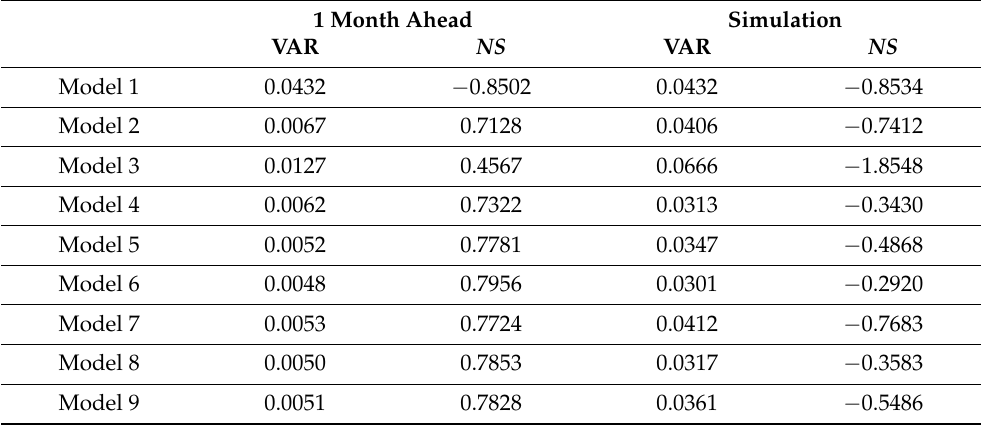
Table 3. VAR and NS values estimated for the testing set of data, for the one month ahead prediction and